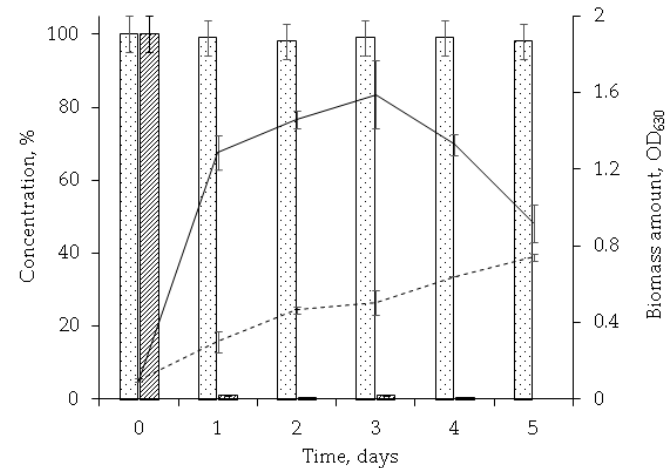
Figure 2. The dynamics of OA transformation by R. rhodochrous IEGM 757 ( ), abiotic control ( ). OD 630 in the presence of OA ( ) and without it ( ). HPLC data of the post-cultural extracts are presented.